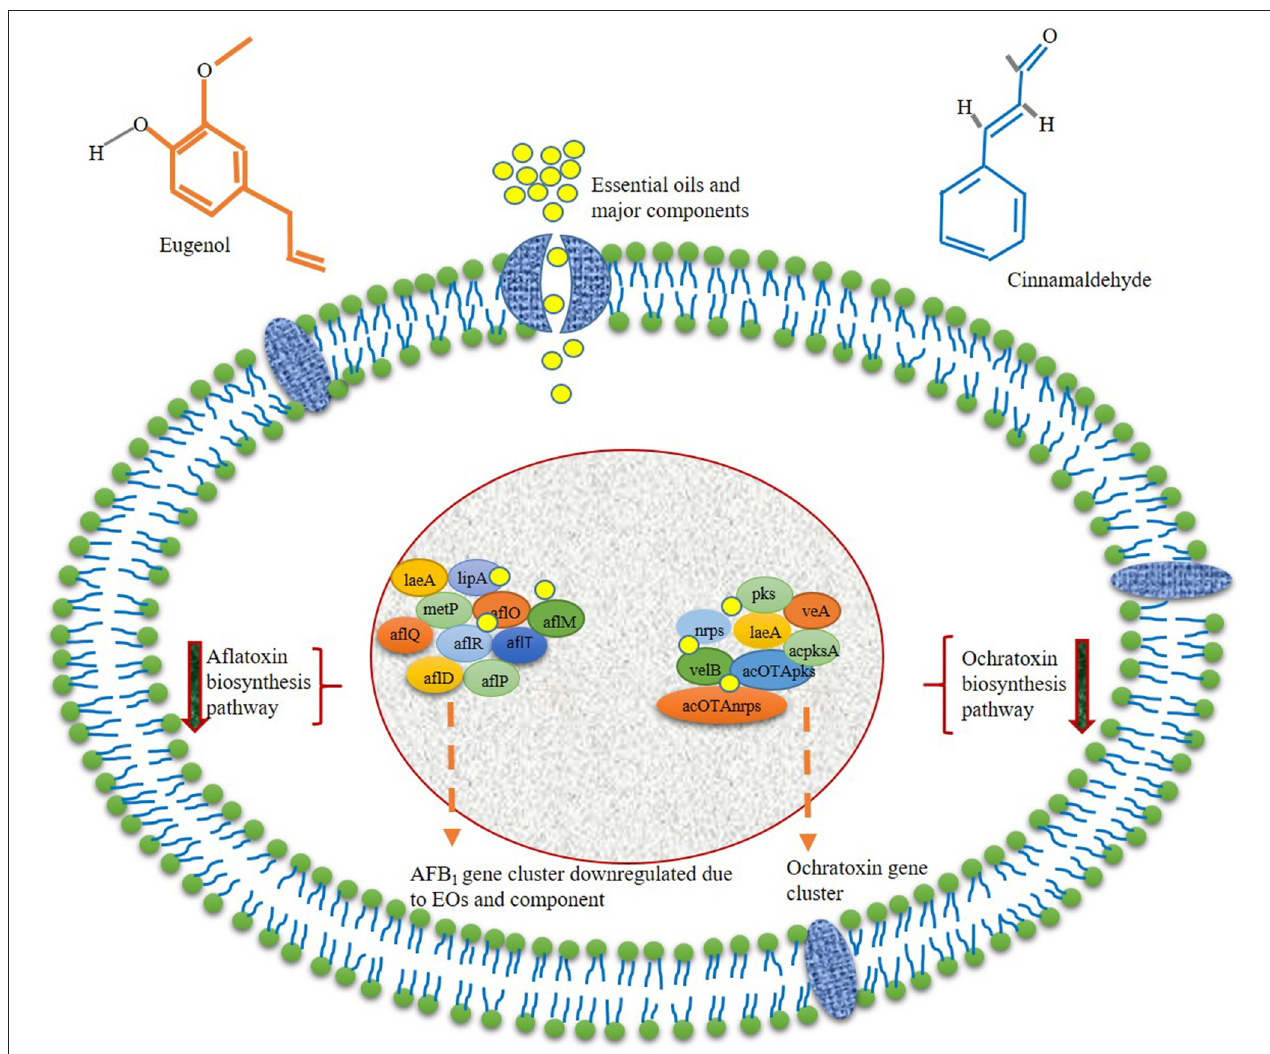
FIGURE 3 | Possible mechanisms of mycotoxin inhibition by interacting gene